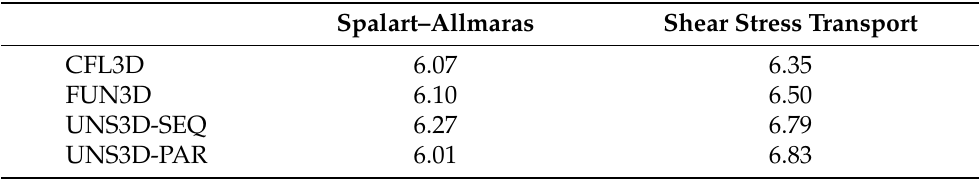
Table 5. Location of reattachment point x / H on backward-facing